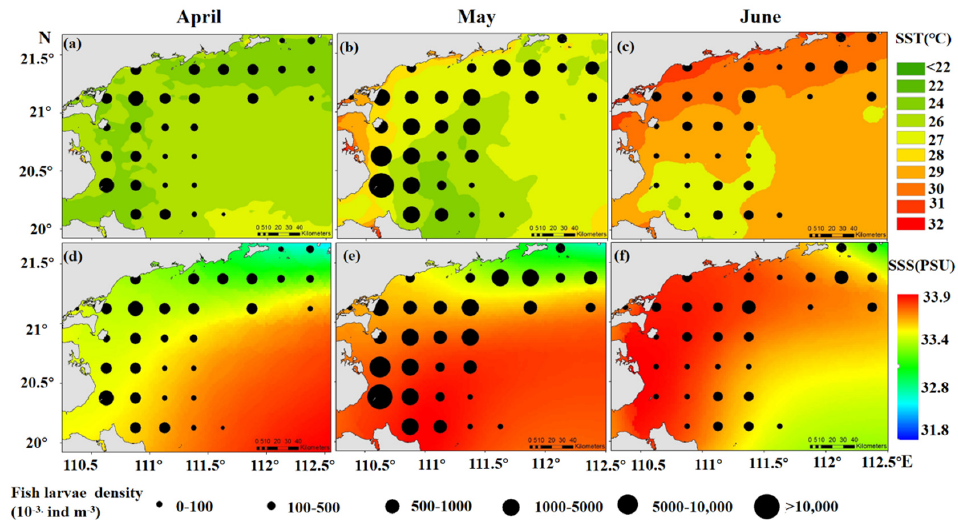
Figure 3. Relationship between spatiotemporal variability of fish larvae, SST, and SSS: ( a ) fish larvae density and SST in April, ( b ) fish larvae density and SST in May, ( c ) fish larvae density and SST in June, ( d ) fish larvae density and SSS in April, ( e ) fish larvae density and SSS in May, ( f ) fish larvae density and SSS in June.